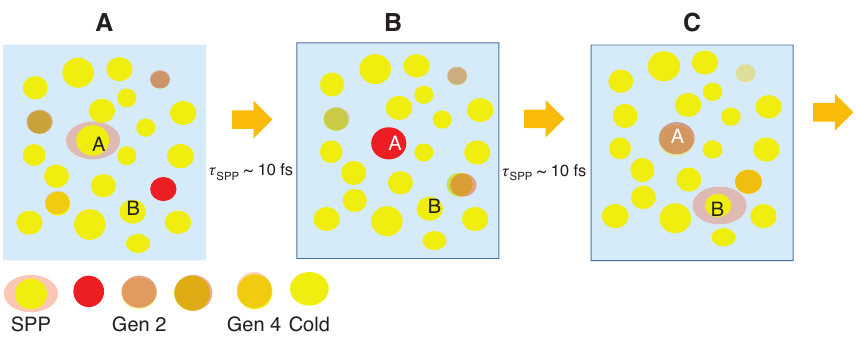
Figure 2: Dynamics of hot carrier generation and decay in the array of metal nanoparticles under typical photoexcitation conditions. At each point in time, only very few SPPs are excited and also very few nanoparticles contain non-equilibrium carriers. For example, in “frame” (A), only one nanoparticle A is excited with SPP and few other nanoparticles tinted red contain non-equilibrium carriers generated by previously excited and decayed SPPs, while a majority of nanoparticles tinted yellow remain “cold” or unexcited. In frame (B), the SPP on nanoparticle A has decayed into a hot electron-hole pair and no SPPs are present. In frame (C), a new SPP is excited on nanoparticle B while the existing non-equilibrium carriers continue to further cool